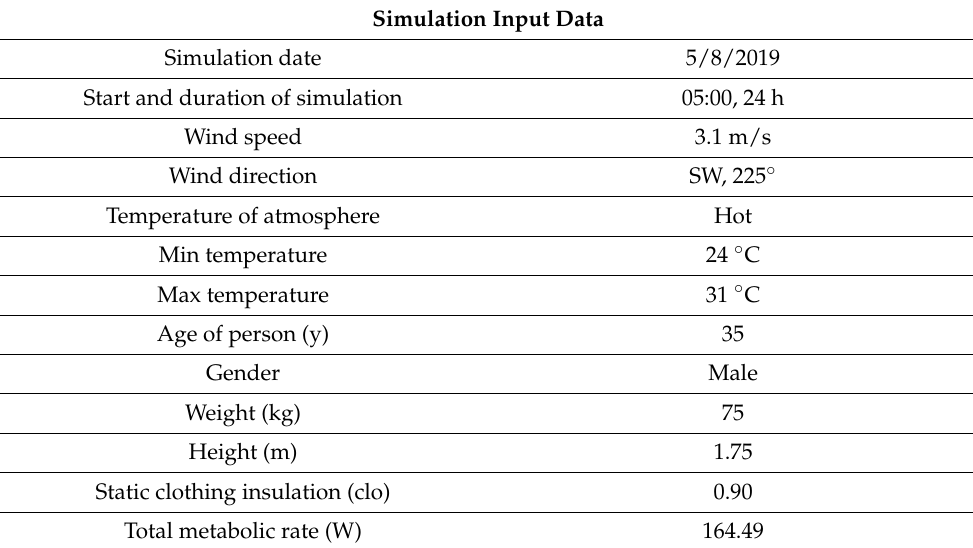
Figure 8. Procedure for creating the model of the study area. Table 2. Input data of the study area in ENVI-met© software. (The meteorological factors come from https://www.meteo.gr/ (accessed on 9 December 2020) [48], and the human parameters were randomly selected.)